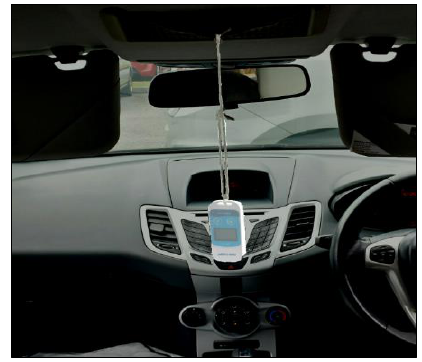
Figure 5. Calibrated data logger Figure 6. Placement of equipment inside the car